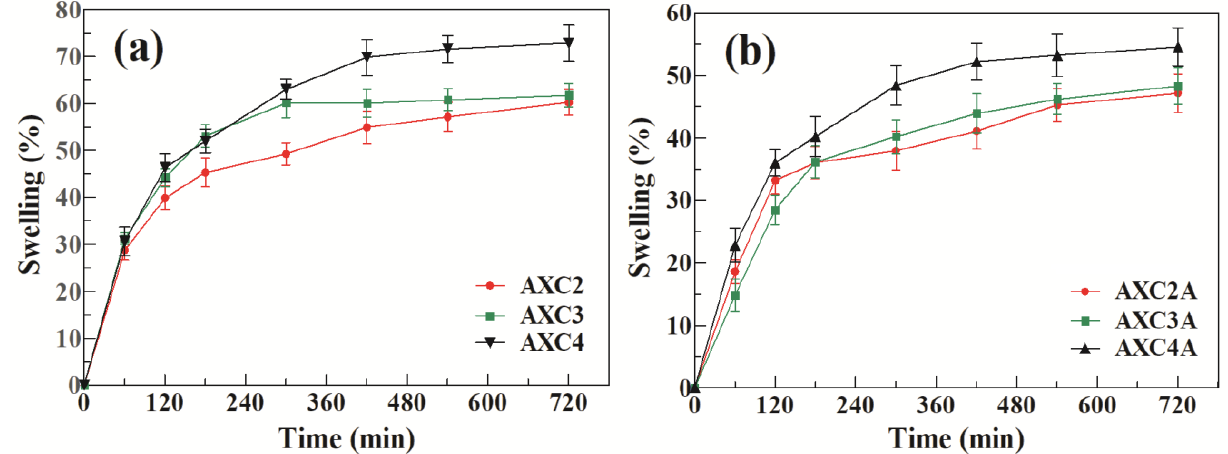
Figure 4. Expansion profiles of the ( a ) blank and ( b ) AMK-loaded AX-CMC composite films.